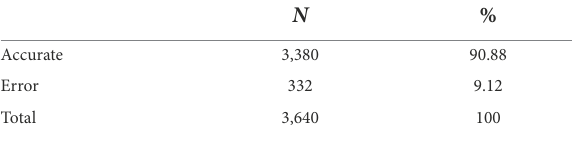
TABLE 2 Recognition accuracy rate of the model of factors affecting individual interest in PE of primary and middle school